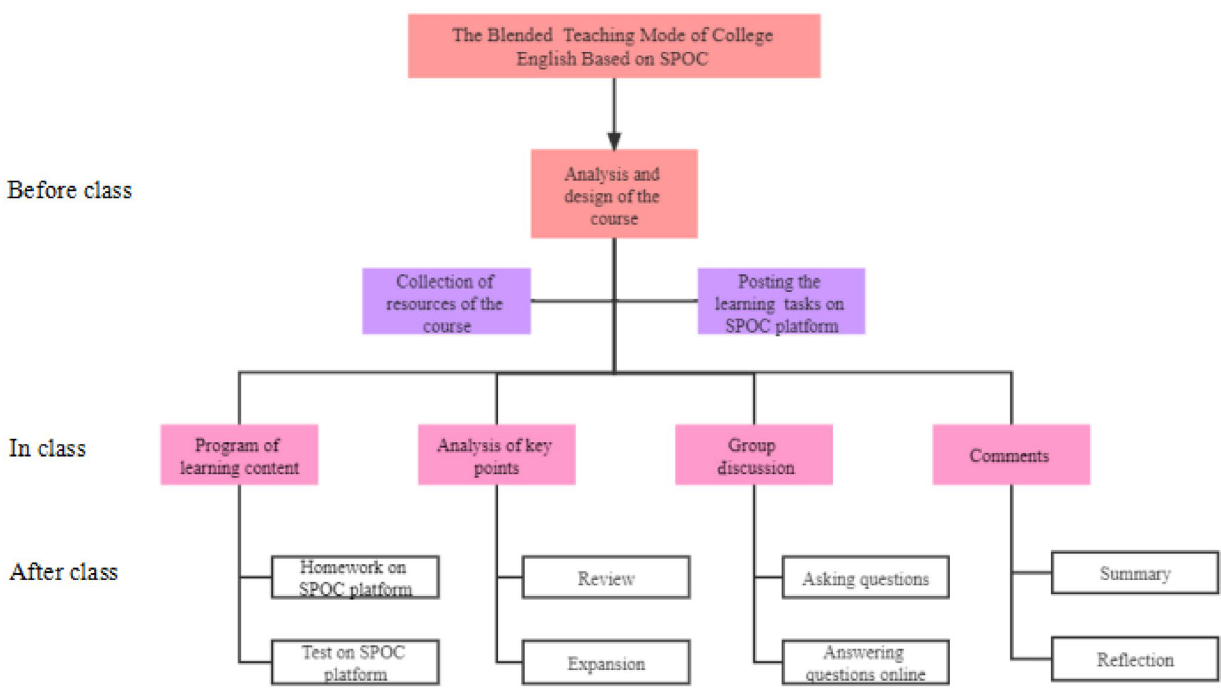
Fig. 2 The blended teaching mode of college English based on